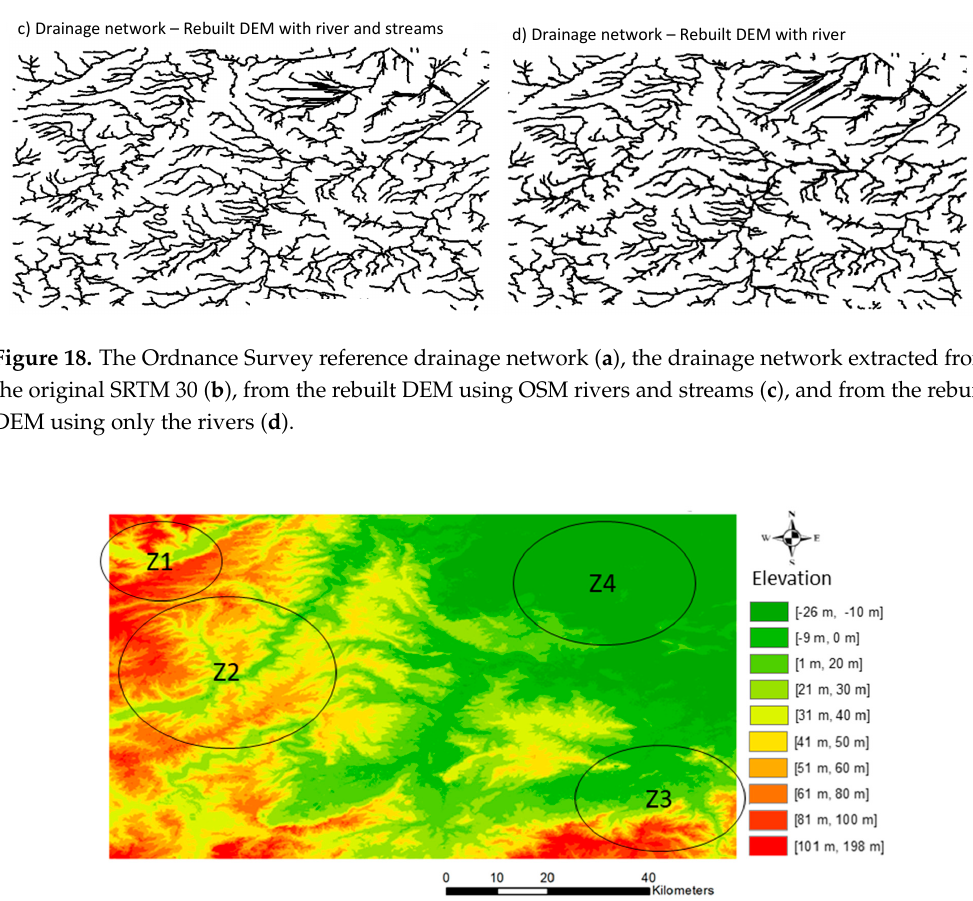
Figure 19. Zones defined inside the study area.